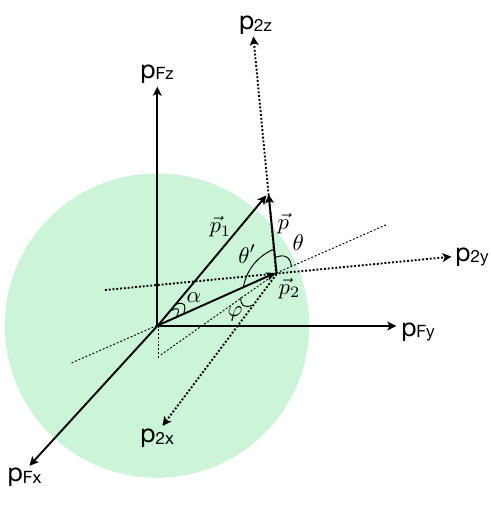
Figure 2 . The coordinate system used in performing the integral